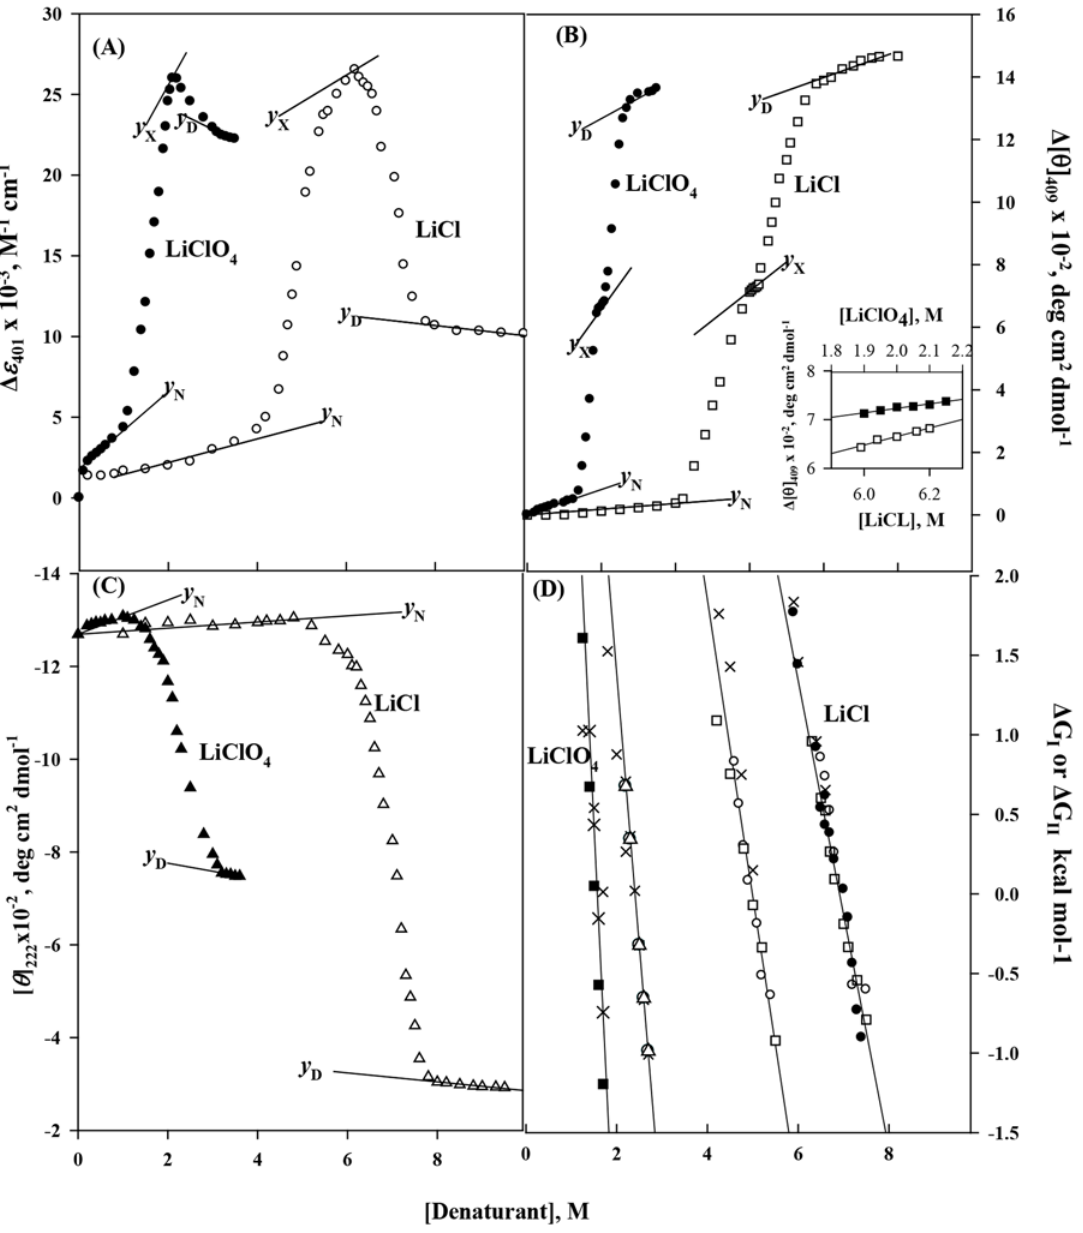
Fig 2. Equilibrium denaturation curves of cyt- c in the presence of LiCl ( Ο ) and LiClO 4 ( Δ ) at pH 6.0 and 25°C. Denaturation was monitored by Δ ε 400 (A), Δ [ θ ] 409 (B) and [ θ ] 222 (C). Inset in panel (B) shows the plot for the dependence of the optical property of the X state ( y X ) on [denaturant] on the expanded scale. Panel (D) shows plots of Δ G I and Δ G II versus [denaturant]. In this panel filled symbols are obtained from the studies of thermal denaturation in the presence of weak salt